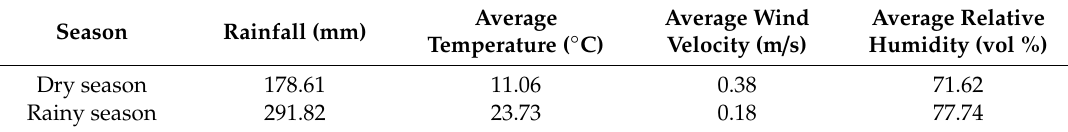
Table 3. Meteorological data of the dry and rainy